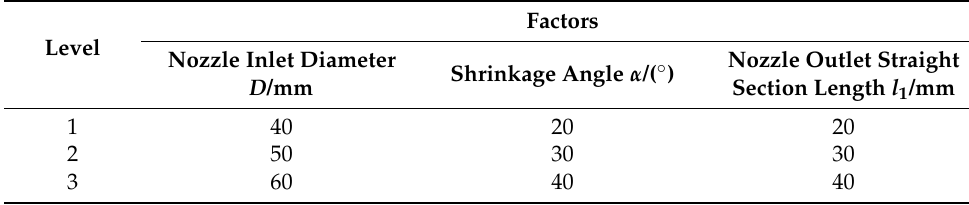
Table 4. Factors and levels of influence of the orthogonal test.